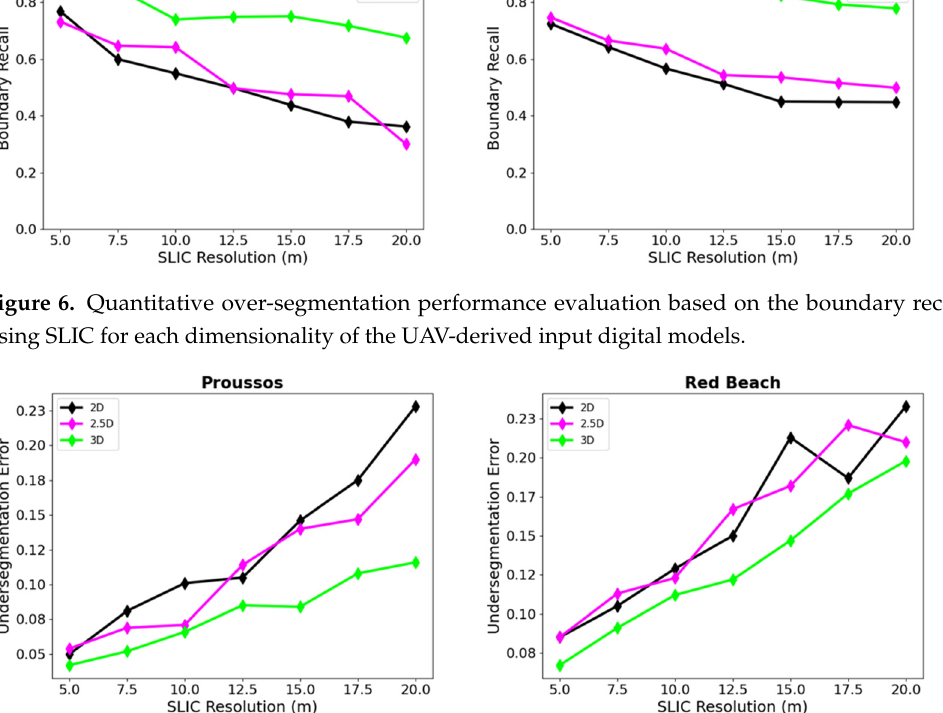
Figure 7. Quantitative over-segmentation performance evaluation based on the under-segmentation error using SLIC for each dimensionality of the UAV-derived input digital models.